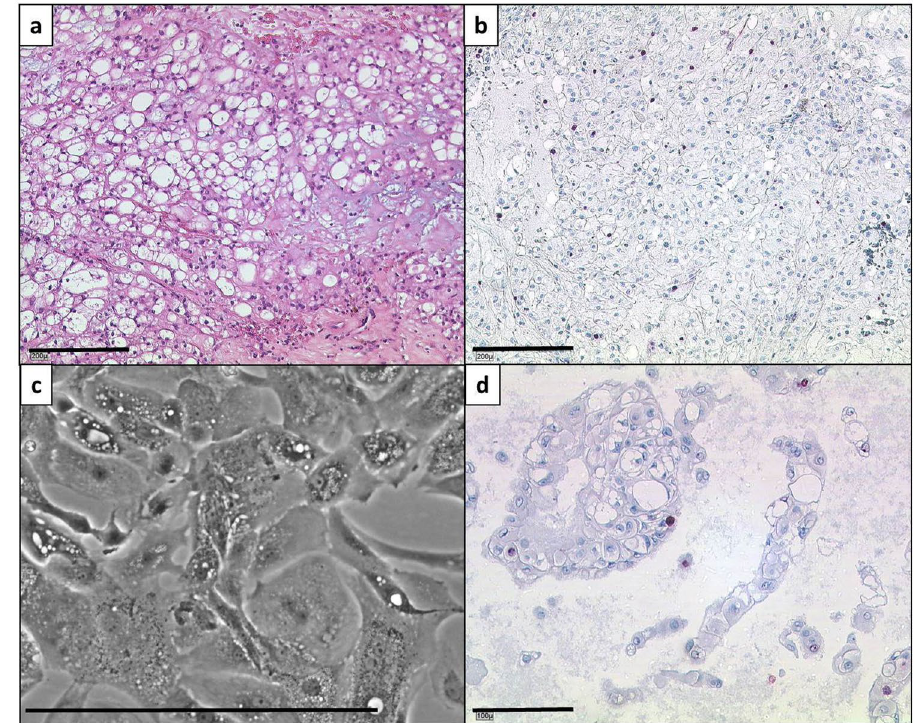
Figure 1. Morphology and proliferation rate detection of the parental tumour and the U-CH14 cell line. ( a ) Section of the parental tumour. The cells show the typical physaliphorous appearance. The tumour is classified as not otherwise specified (NOS) subtype. ( b ) Ki-67 staining of a parental tumour section. The proliferation index is below 5%. ( c ) Phase contrast image of the U-CH14 cell line. The typical morphology is conserved in vitro . ( d ) Proliferation index of U-CH14 ( < 5%; Ki-67 staining). Lines indicate 200 µ m ( a + b ) or 100 µ m ( c + d